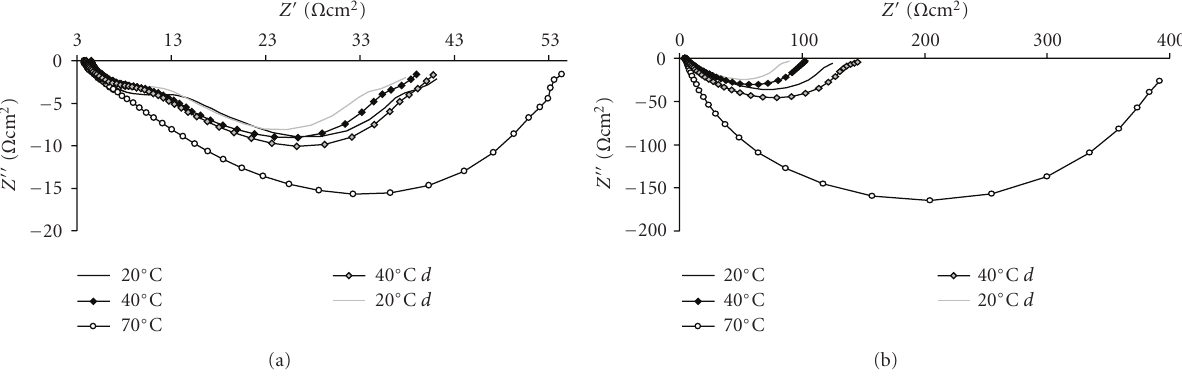
Figure 4: Typical Nyquist plots for the nonsintered cells at di ff erent temperatures: cell type L-NS, measurement day 1 (a) and 76 (b). Letter “ d ” after the temperature value indicates the downward sweep of the temperature cycle. Z (cid:4) : real impedance; Z (cid:4)(cid:4) : imaginary impedance.